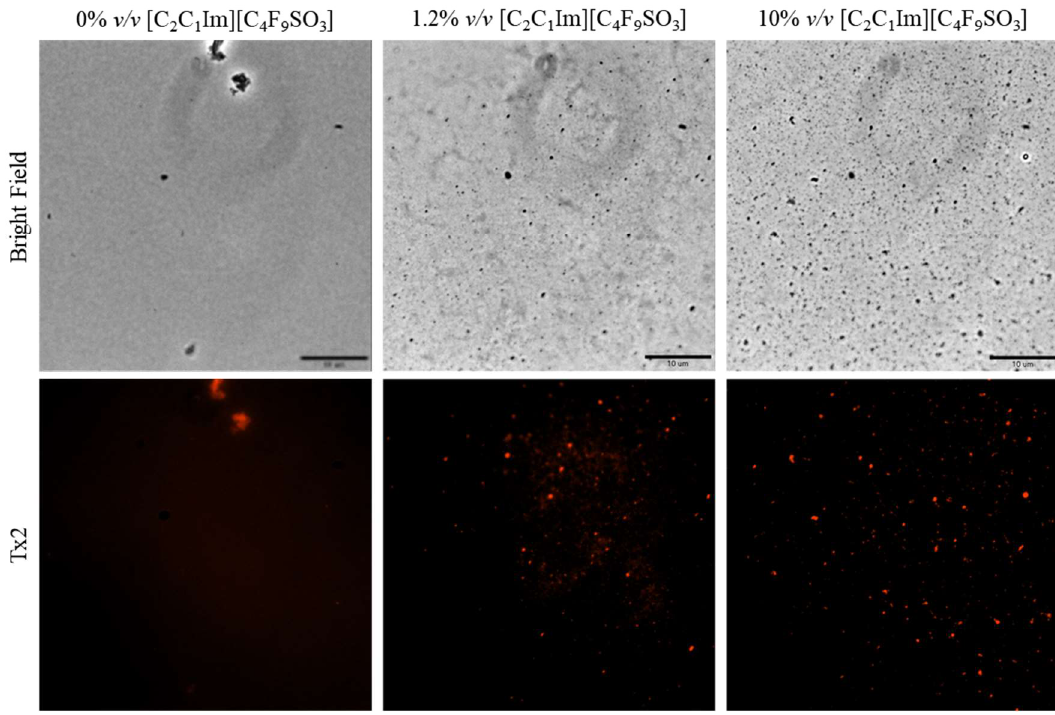
Figure 14. Fluorescence microscopy of Lys-Rho in the presence of 0, 1.2, and 10% v / v [C 2 C 1 Im][C 4 F 9 SO 3 ]. Scale bar corresponds to 10 µm.